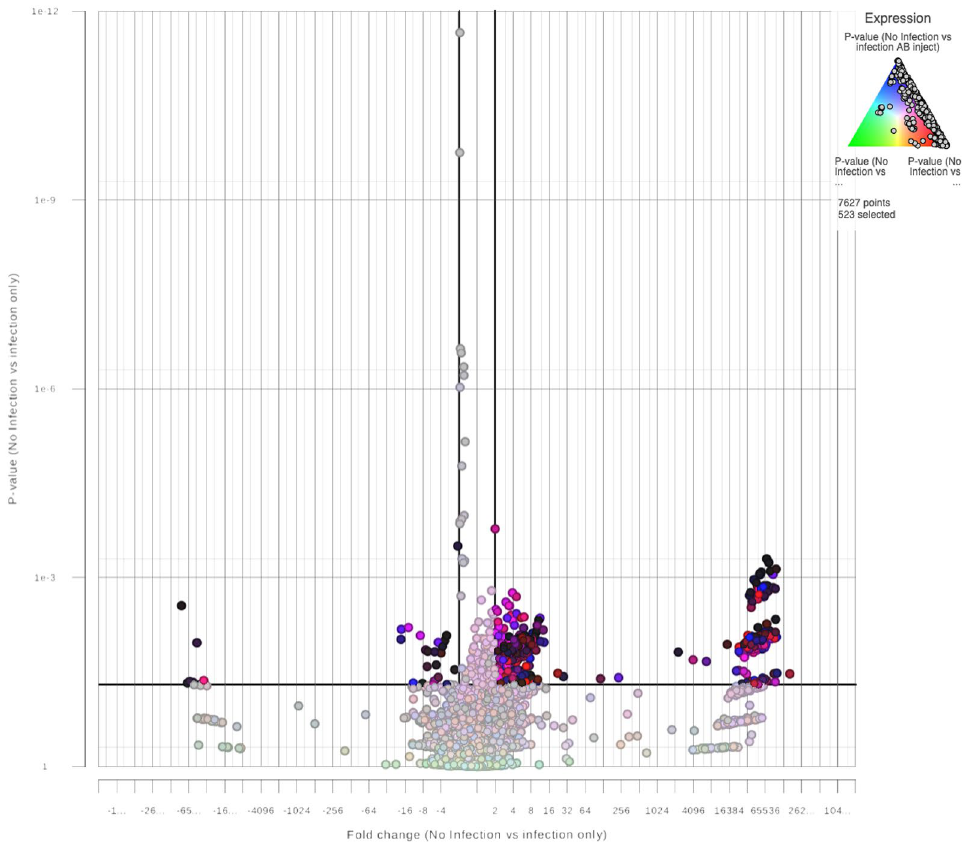
Figure 1. Controls vs treated. A Volcano plot for 19 blood samples indicating likely significant expression of transcripts (* = p < 0.05) based on treatment type of Capra hircus following STAR alignment and GSA differential analysis for transcript sequences of 7,627 identified transcripts (points selected) on 7 dpi. The fold change indicates downregulation (* = < − 2), no change (NC; * = > − 2, * = < 2), and upregulation (* = > 2) transcript distribution when comparing control samples to treatment samples as expressed against a Numeric Triad of P-values for controls vs treated (green), controls vs ZA (red) and controls vs AB